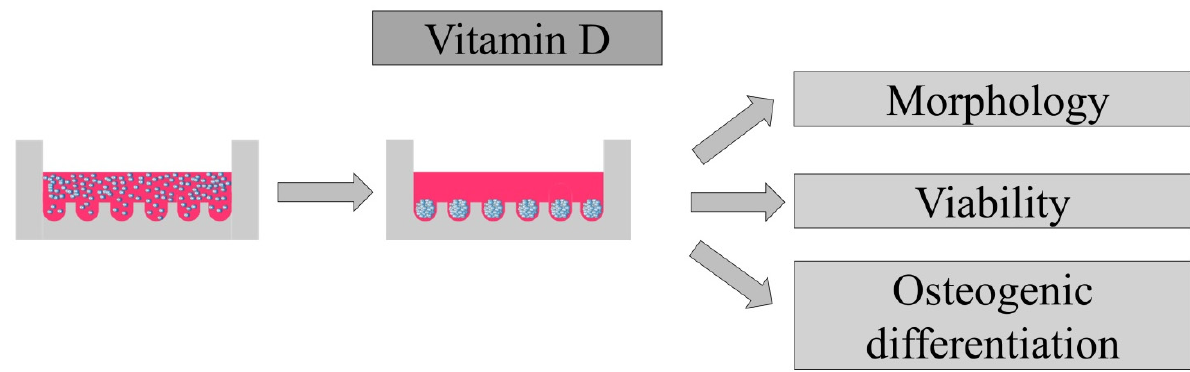
Figure 1. Study flow diagram illustrating the overview.